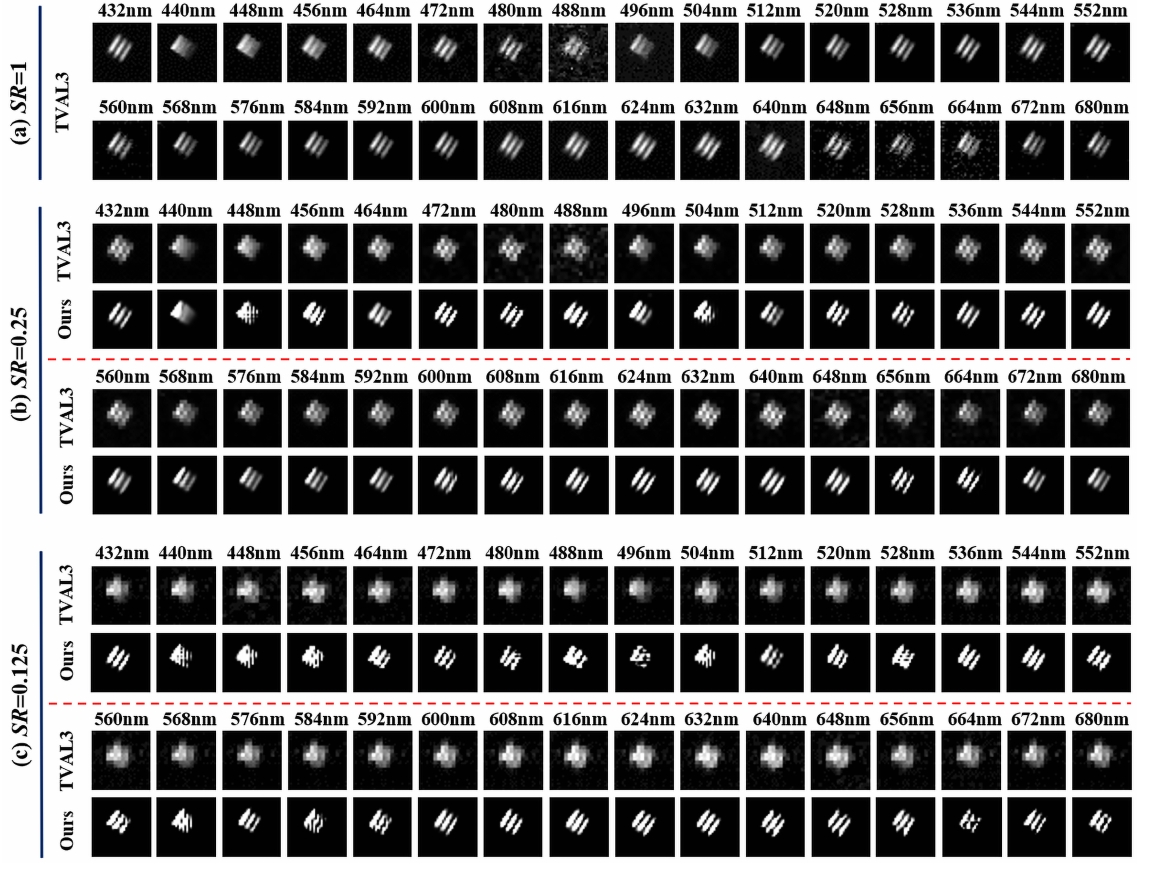
Figure 5. The reconstructed 32 spectral bands hyperspectral images for a unit component of a USAF1951 resolution plate. Spectrum range is from 432 to 680 nm and the image size is 32 × 32 pixels. The reconstruction images using TVAL3 at the SR of ( a ) 100% and the ones using TVAL3 and the proposed method at the SR of ( b ) 25% and ( c ) 12.5%,